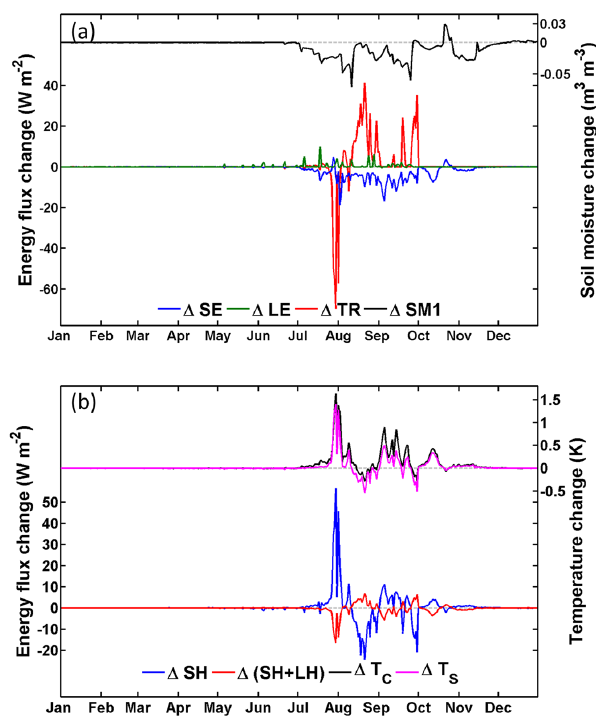
Figure 8. Same as Fig. 7, but for the HAPEX